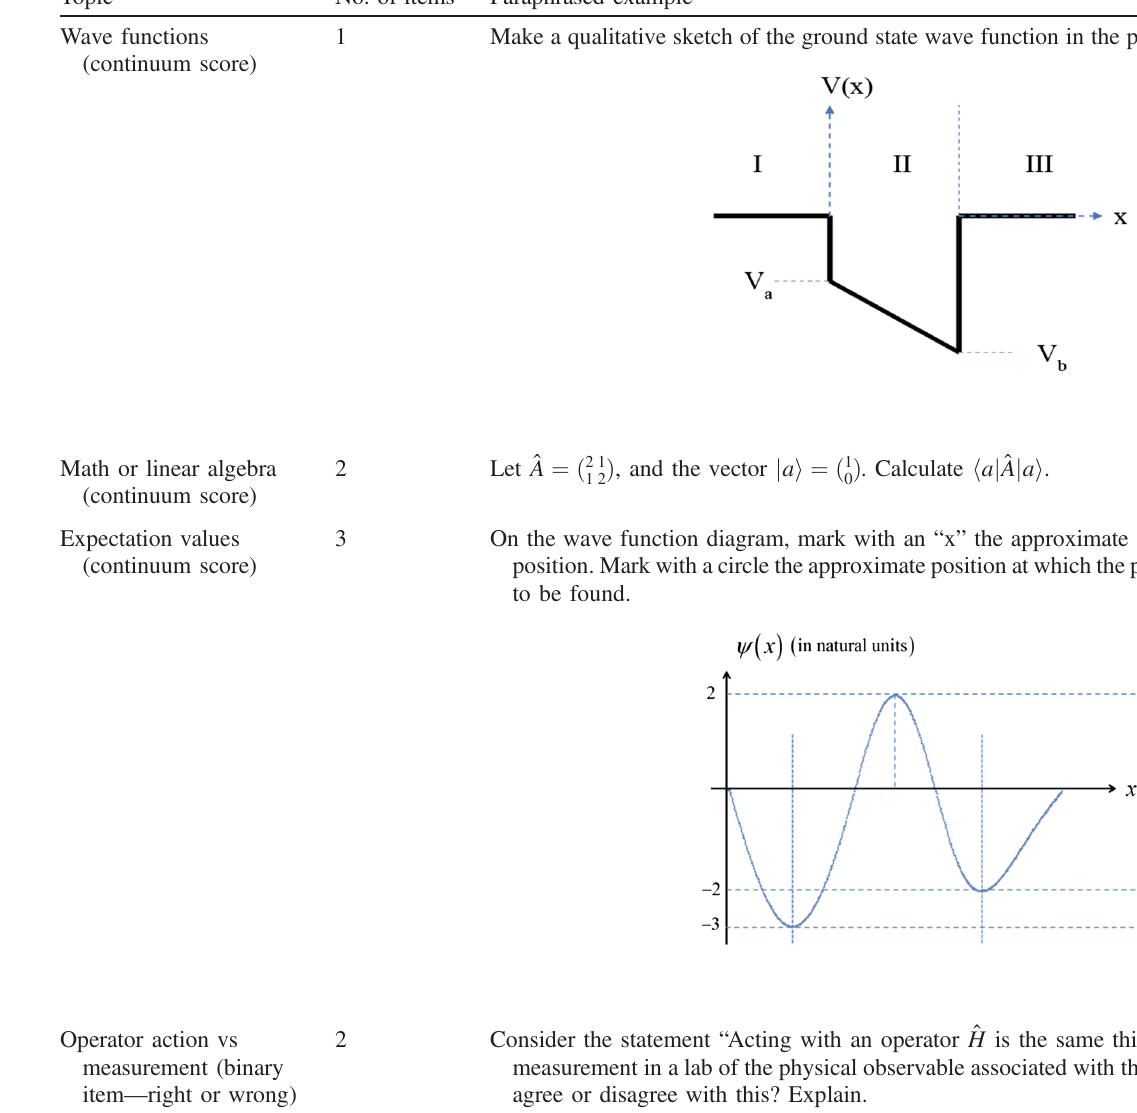
TABLE II. Some topics emphasized on the GQMA, number of items covering the topic, and an example item for each topic. This is not an exhaustive list of GQMA items. In total, there were 14 topics and 34 items in the GQMA used in this study. 24 were scored out of 10 points, such that the scores are approximately a continuum; 10 were graded as simply “ right ” or “ wrong. ” Topic No. of